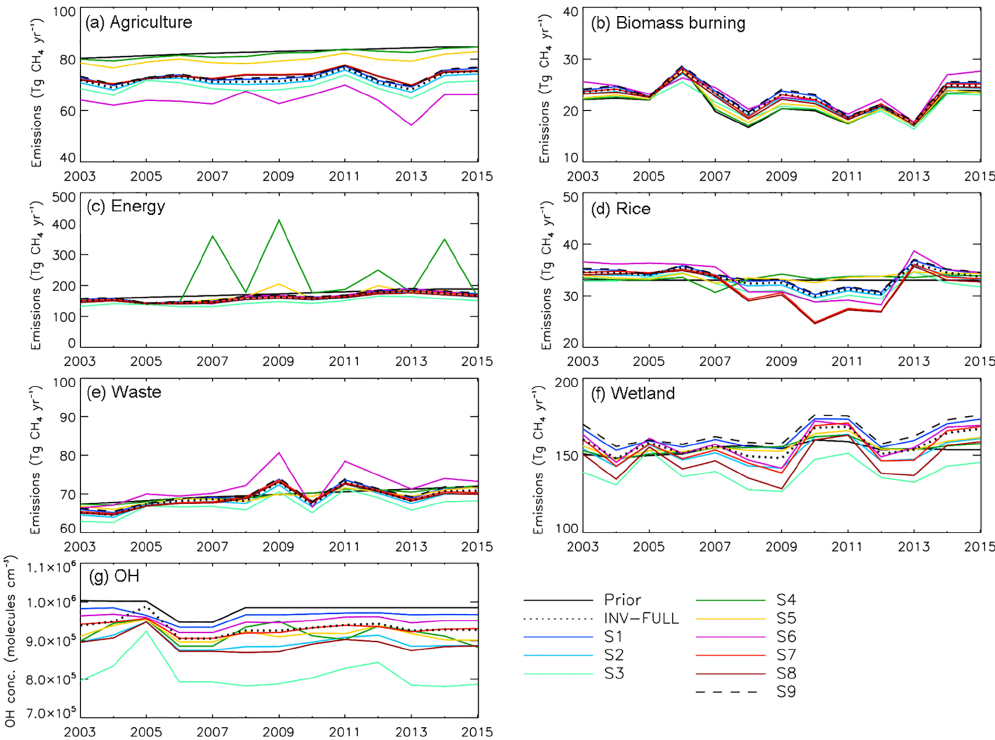
Figure 8. (a–f) Annual mean CH 4 emissions (TgCH 4 yr − 1 ) from different sectors for global prior (black solid line) and INV-FULL (black dotted line) estimates. (g) Same as (a–f) but for global mean OH (moleculescm − 3 ). Additional lines in each panel show sensitivity inversions with different emissions and OH uncertainties (coloured lines) and an inversion assuming no change in OH (black dashed